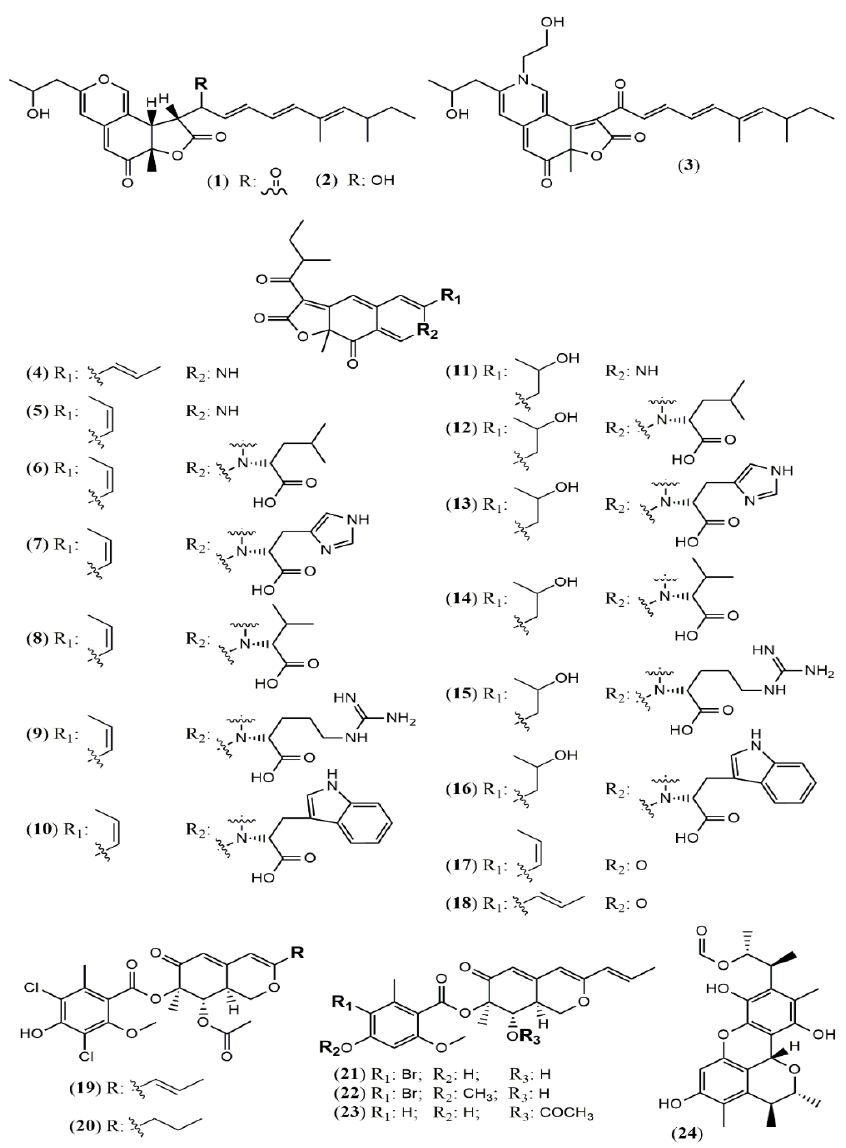
Figure 2. Chemical structures of Aspergillus azaphilones 1–2 : sassafrin E-F; 3 : sassafrinamine A; 4 : trans -cavernamine; 5 : cis -cavernamine; 6–10 : Leu, His, Val, Arg, Trp-cavernamine derivatives; 11 : hydroxy-cavernamines; 12–16 : Leu, His, Val, Arg and Trp-hydroxy-cavernamines.; 17 : cis -cav- itrinol Q [33–36].